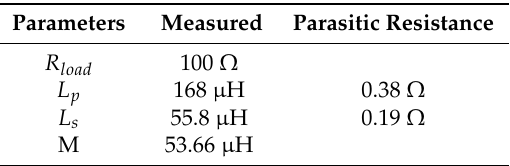
Table 2. Initial parameters used in the design procedure.